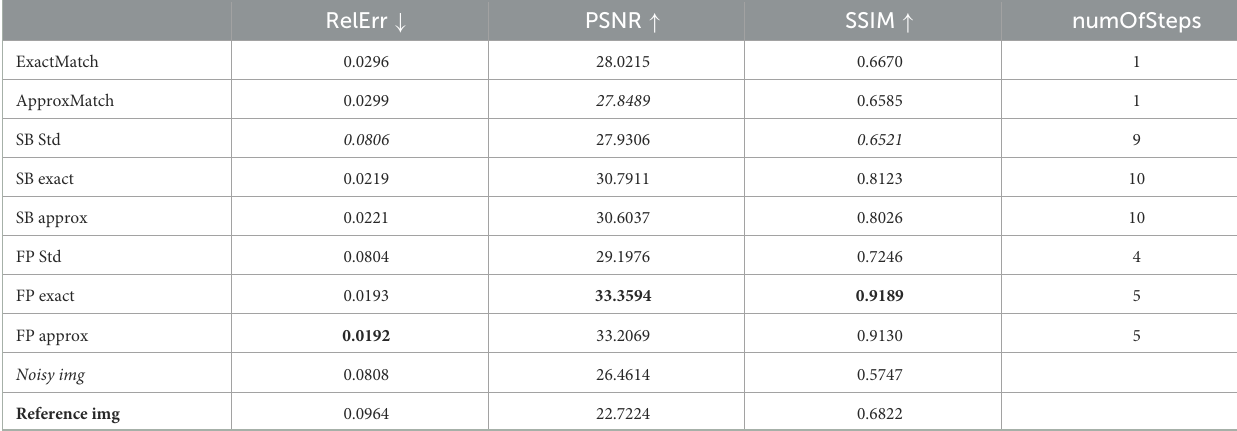
TABLE 2 Case 2: Comparison results, when the target image is collected at a distance of –5 mm from the original